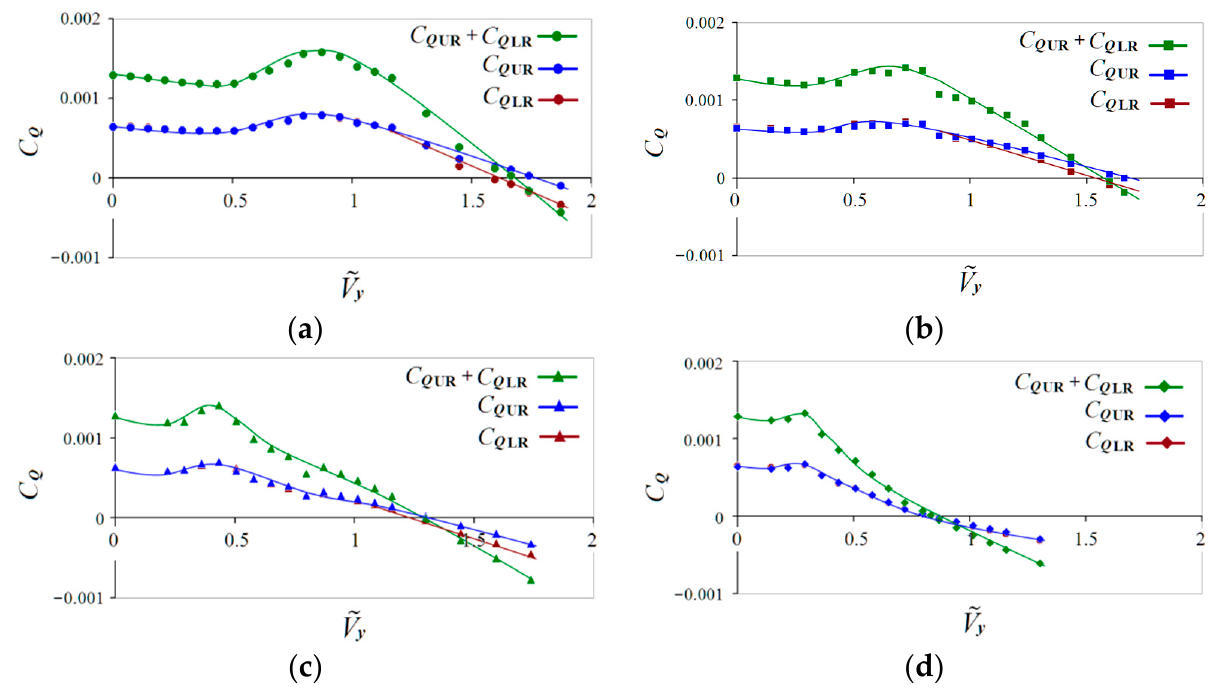
Figure 11. Dependencies of the UR, LR and total (UR + LR) torque coefficients C Q vs. non-dimensional vertical descent speed (cid:101) V y at α R = 30–90 ◦ . ( a ) α R = 90 ◦ ; ( b ) α R = 70 ◦ ; ( c ) α R = 50 ◦ ; ( d ) α R = 30 ◦ .